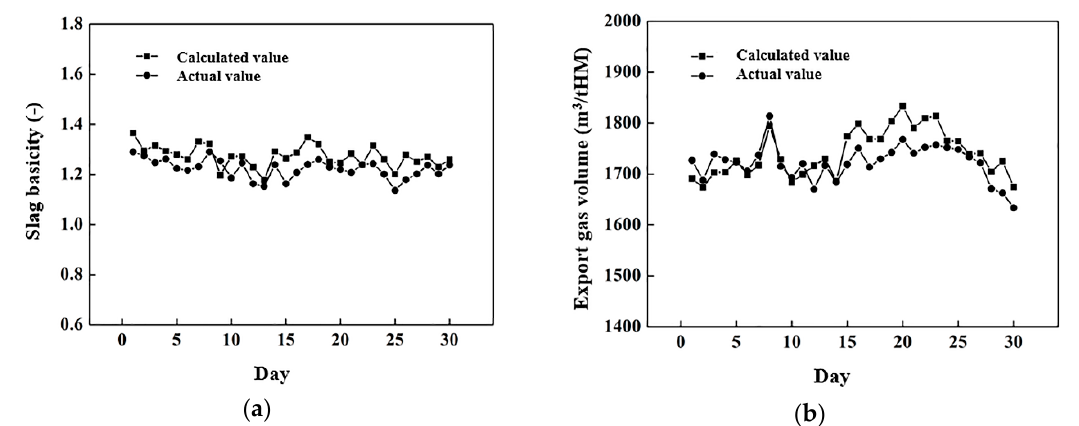
Figure 3. The comparison of actual and predicted values ( a ) slag basicity and ( b ) export gas volume.